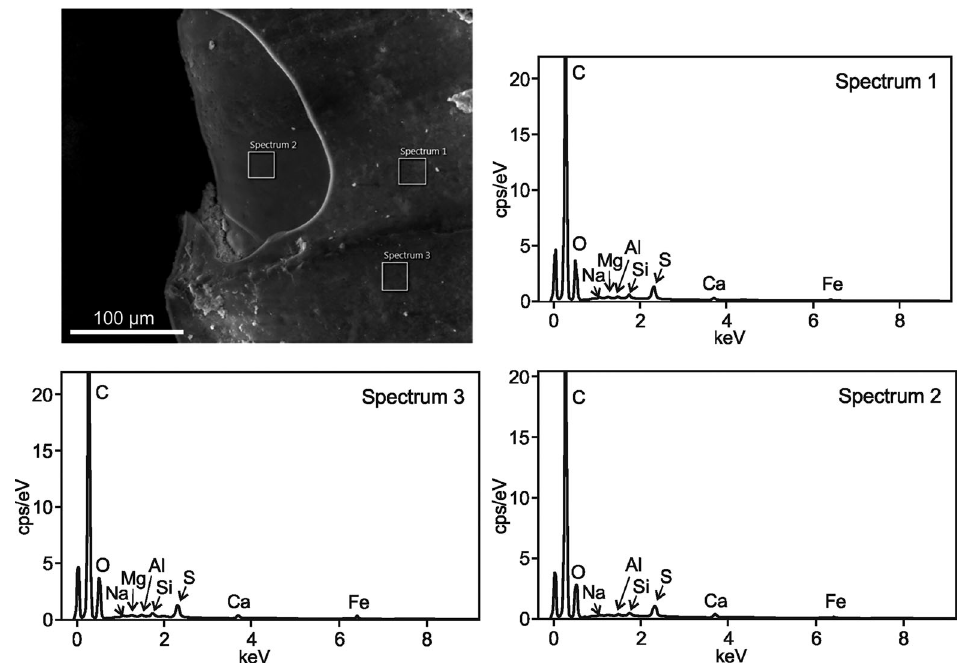
Fig. 3. Composition of Byronia jaegeri sp. nov. tubes. Cps, counts per